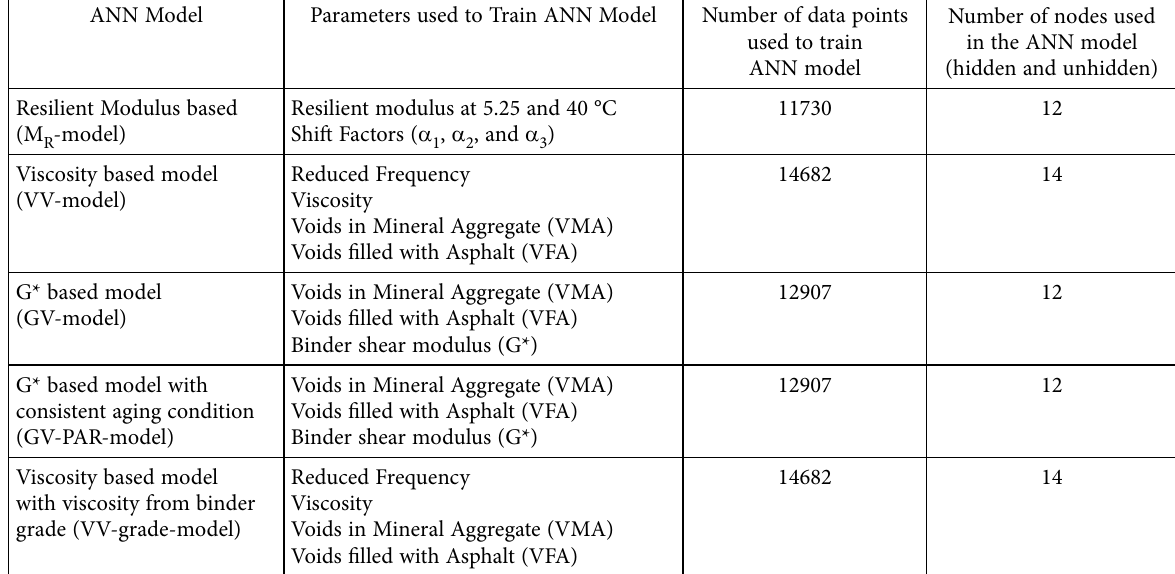
Table 6. Summary of parameters used to train LTPP ANN